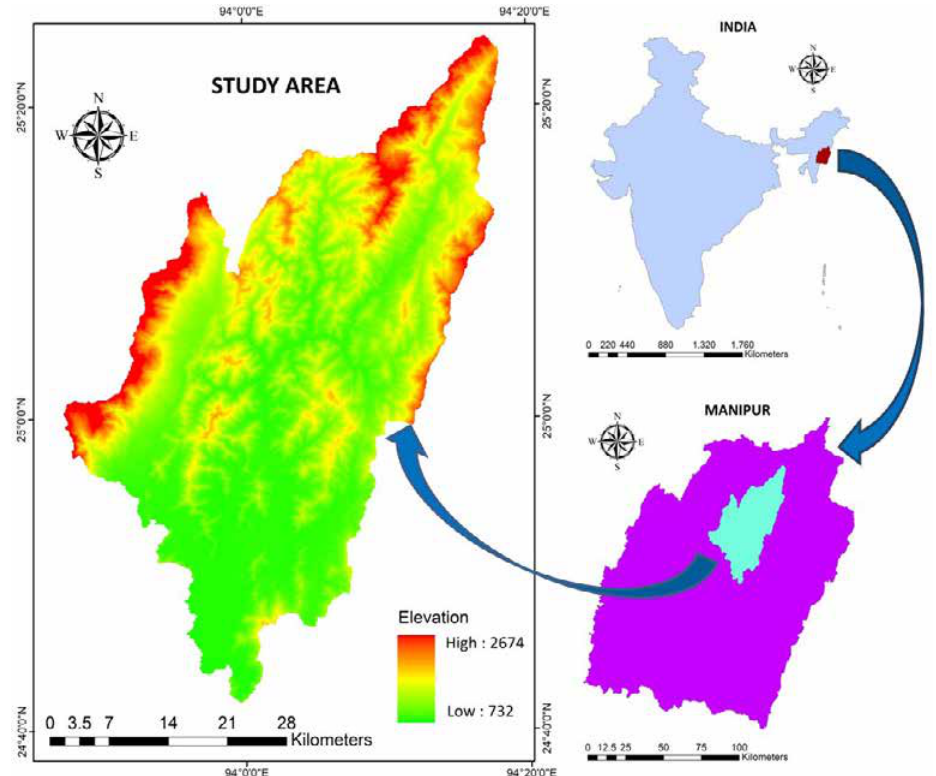
Fig. 1: Geographic location of the study area in the land suitability potential zones for rice crop cultivation along with land use/ land cover in the Imphal-IrilRiver catchment, Manipur,